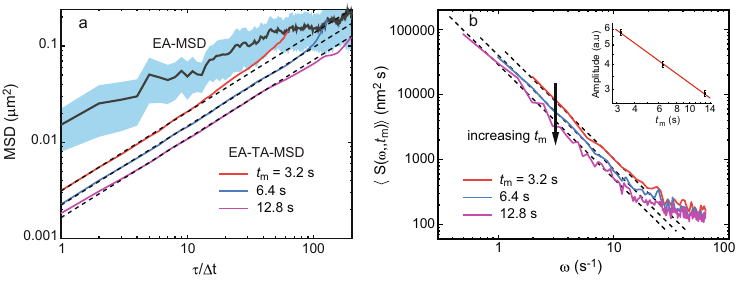
Fig. 4 Analysis of Nav1.6 experimental trajectories in the soma of hippocampal neurons. a The time-averaged MSD is different from the ensemble- averaged MSD (gray upper line). The shaded region indicates the 95% con fi dence interval for the ensemble-averaged MSD. The time-averaged MSD scales with the lag time as τ 0.81±0.05 (dashed lines), while exhibiting aging as it decays with experimental time as 1 = t 1 (cid:3) α 0.54 ± 0.02. b Average spectra are presented for three measurement times. The dashed lines show a scaling 1/ ω 1.75 . Besides the power-law scaling, the spectra exhibit white noise evident at large frequencies, likely due to localization error. The arrow shows the decay in the PSD with measurement time t m . The inset shows the amplitude of the PSD as a function of measurement time in a log-log plot. It shows that the spectrum exhibits aging with a power law scaling 1 = t 1 (cid:3) α , from which α is estimated to be 0.50 ± 0.02. The combined measurements provide four different ways to determine the two relevant m parameters, indicating the consistency of the